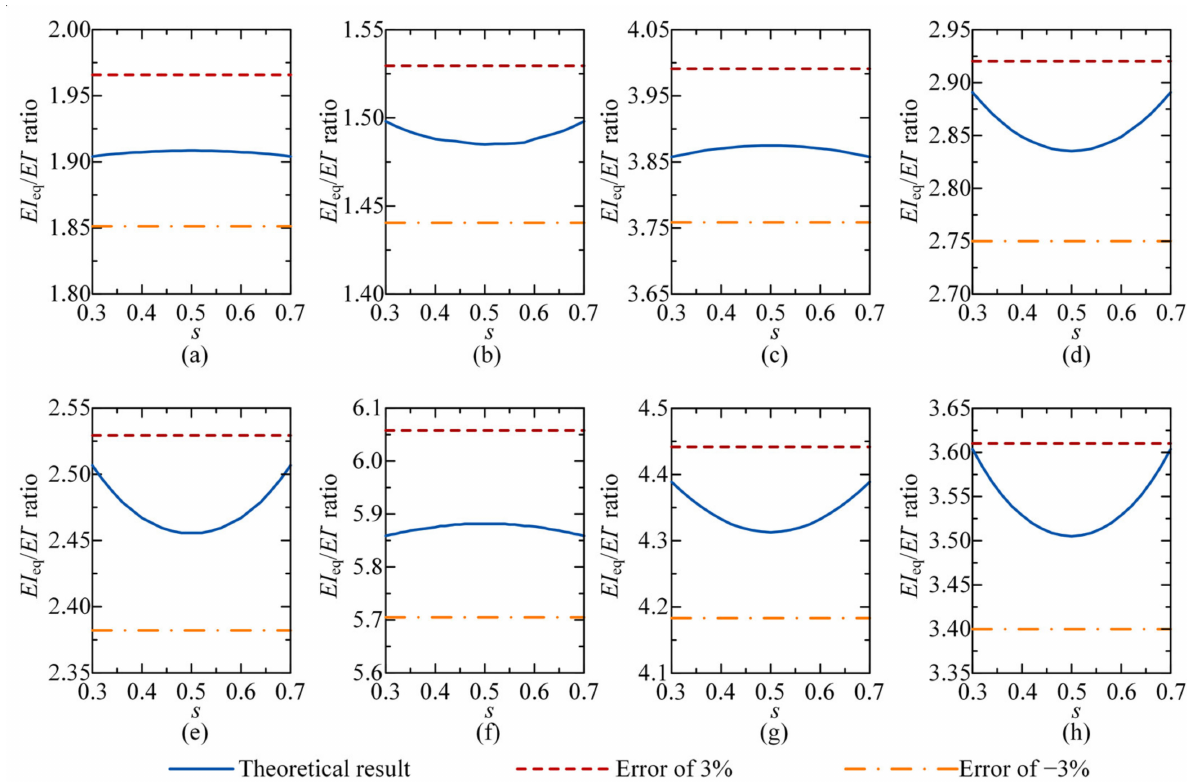
Figure 5. Influence of end rotational constraint stiffness distribution on the equivalent flexural stiffness of the composite beam. (( a ) α = 2, k tot = 10; ( b ) α = 2, k tot = 100; ( c ) α = 4, k tot = 10; ( d ) α = 4, k tot = 50; ( e ) α = 4, k tot = 100; ( f ) α = 6, k tot = 10; ( g ) α = 6, k tot = 50; ( h ) α = 6, k tot =